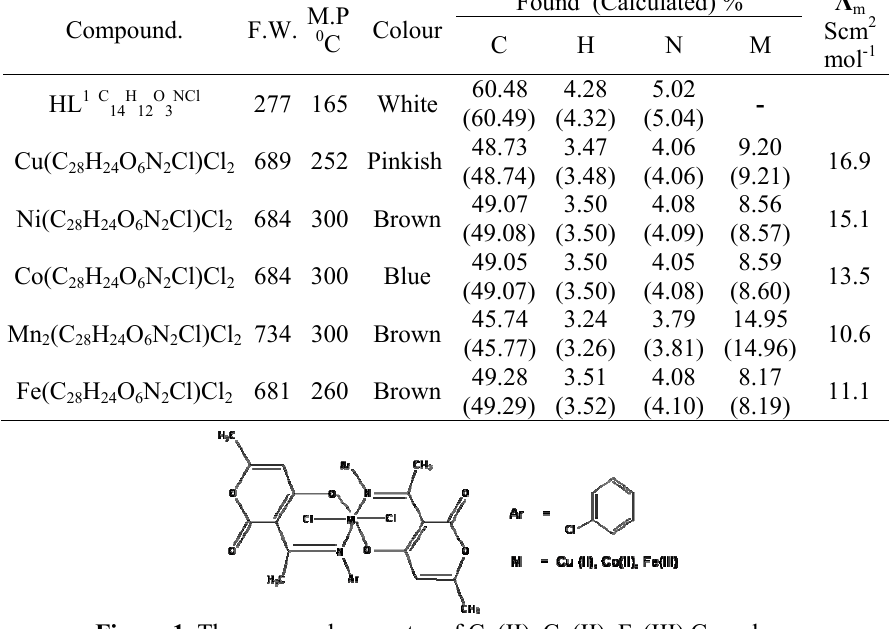
Found (Calculated) %